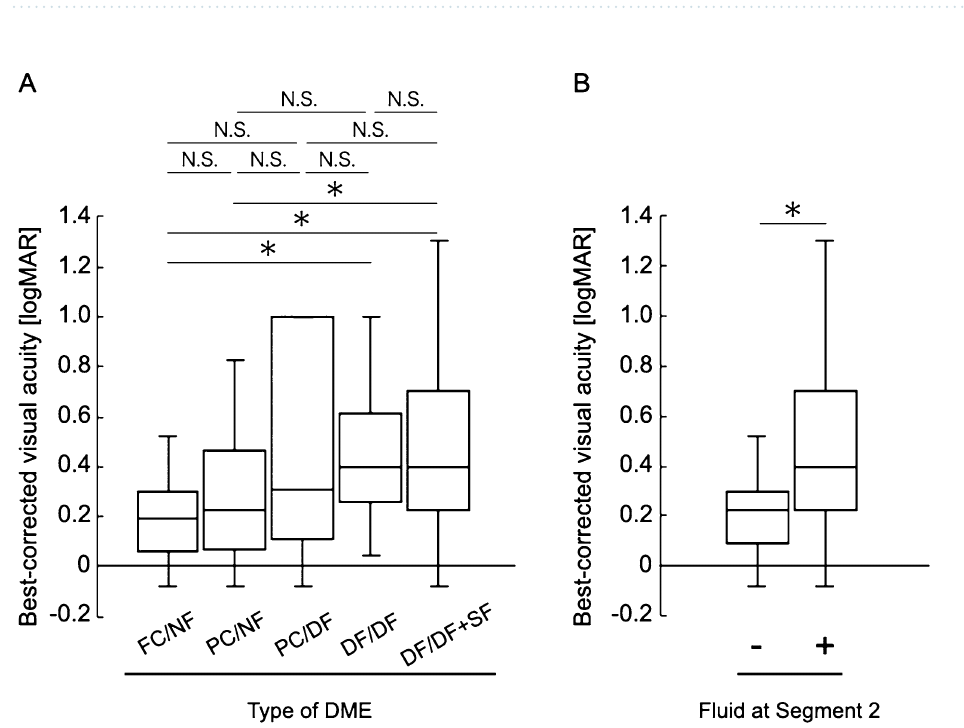
Table 2. Comparisons according to the type of diabetic macular edema determined on the basis of en face images. BCVA best-corrected visual acuity, LogMAR logarithm of the minimal angle of resolution, PVD posterior vitreous detachment.